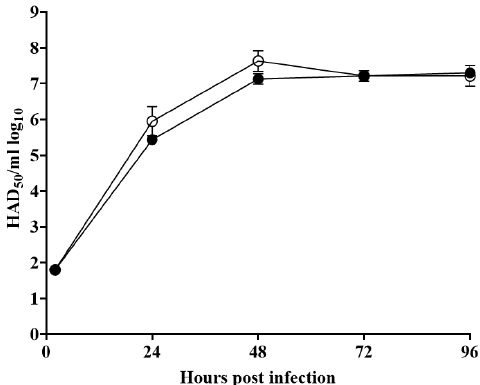
Figure 4. In vitro growth characteristics of ASFV-Georgia- ∆ X69R (filled symbols) and parental (empty symbols) ASFV-Georgia (ASFV-G). Primary swine macrophage cell cultures were infected (MOI = 0.01) with each of the viruses, and virus yield was titrated at the indicated times post-infection. Data represent means and SD from three independent experiments. Sensitivity of virus detection: >1.8 log 10 HAD 50 /mL.